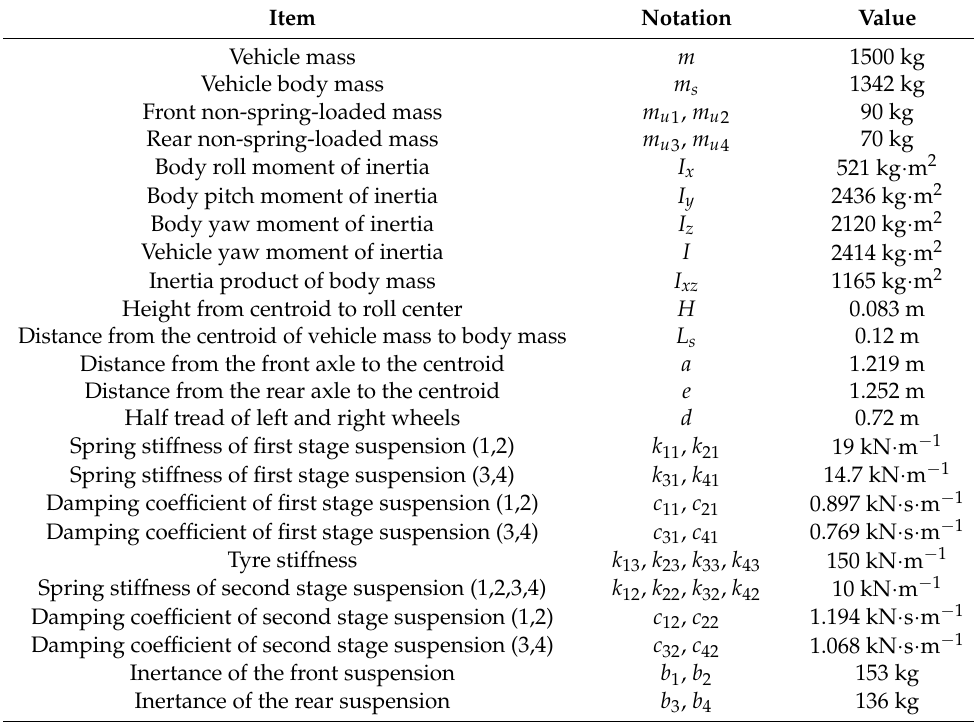
Table 1. Parameters of the vehicle model.